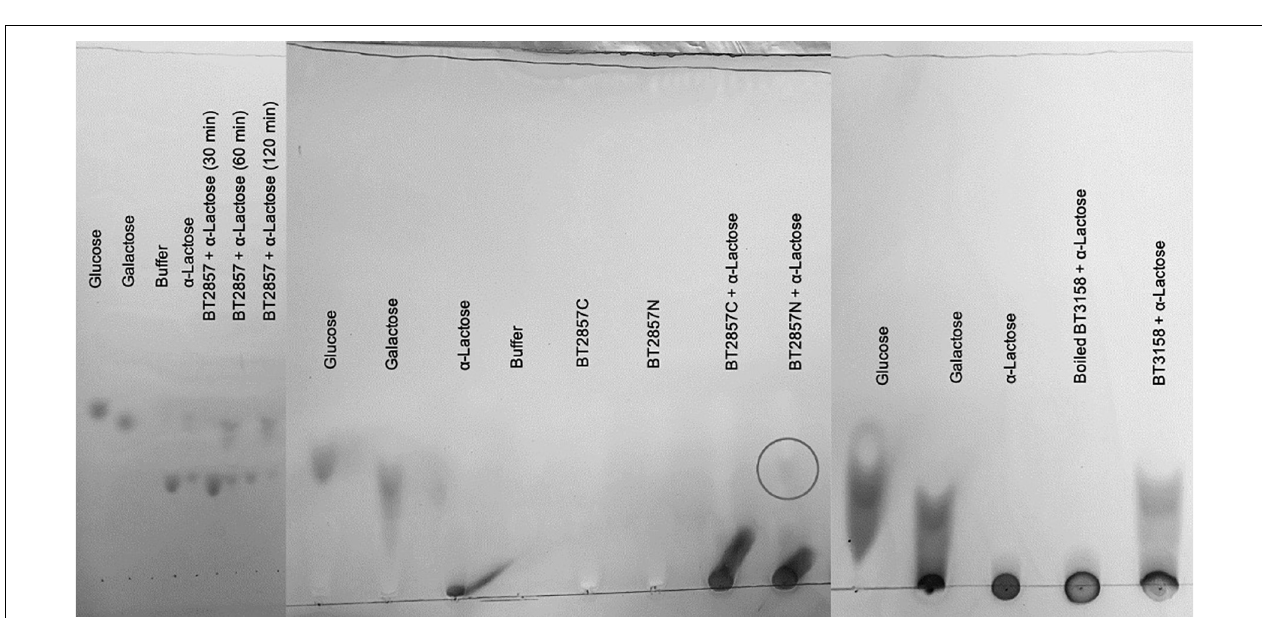
FIGURE 7 | Chair-conformations of (A) p NP-a-D-galactopyranoside, (B) p NP- β -D-galactopyranoside, and (C) α -(1,4)-lactose. The flexibility of the glycosidic bond in α -(1,4)-lactose may permit accommodation by the SusE-like proteins characterized herein or could be the result of background β -(1,4)-lactose contamination in the sample.